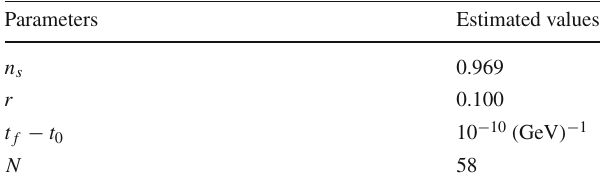
Table 1 clearly indicates that the present model may √ h 0 (cid:13) 10 − 7 M 2